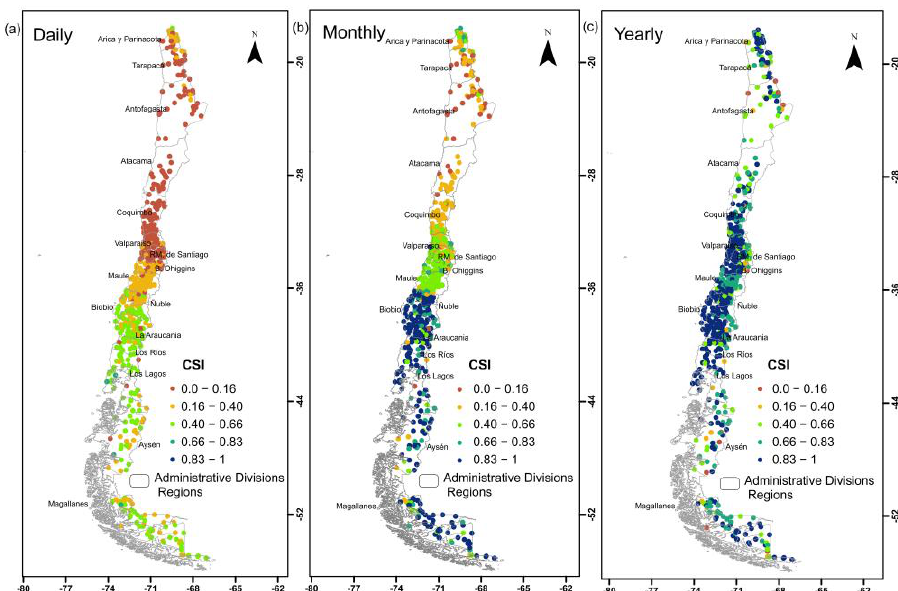
Figure 8. Daily, Monthly, and Yearly FAR for IMERG Early product.